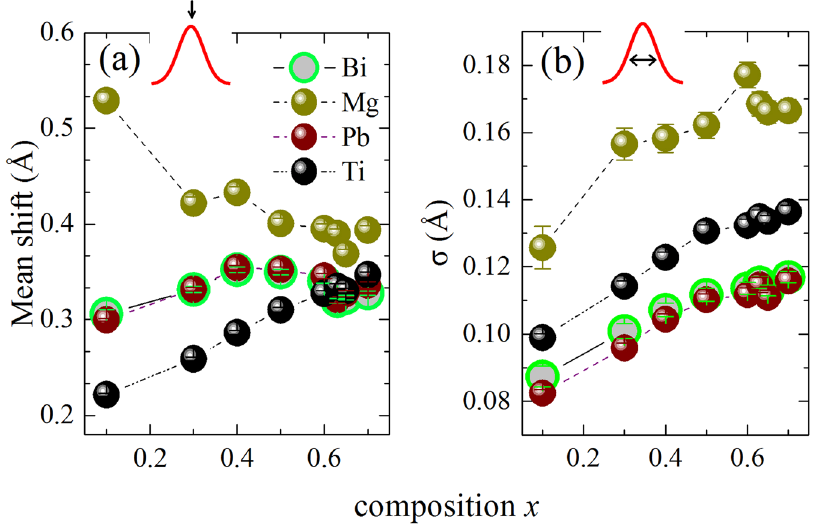
Figure 4. Mean magnitudes and standard deviations σ of the cationic polar displacements determined from the centre of respective oxygen polyhedron as a function of composition.